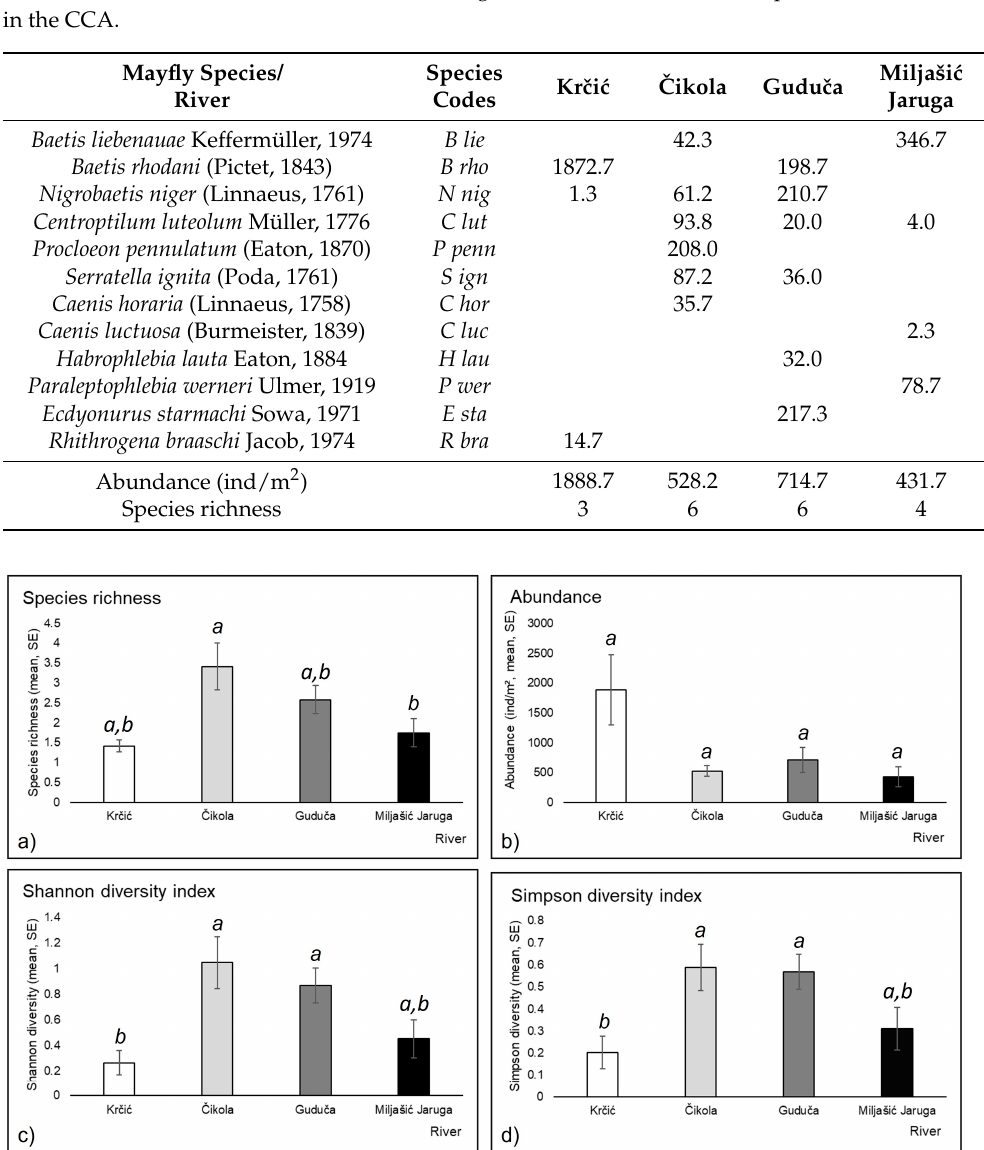
Figure 4. Mayfly assemblage metrics at four intermittent rivers in the karst Mediterranean region of the Balkans, shown as mean with standard error (SE): ( a ) species richness, ( b ) abundance (individuals per m 2 ), ( c ) Shannon, and ( d ) Simpson diversity indices.